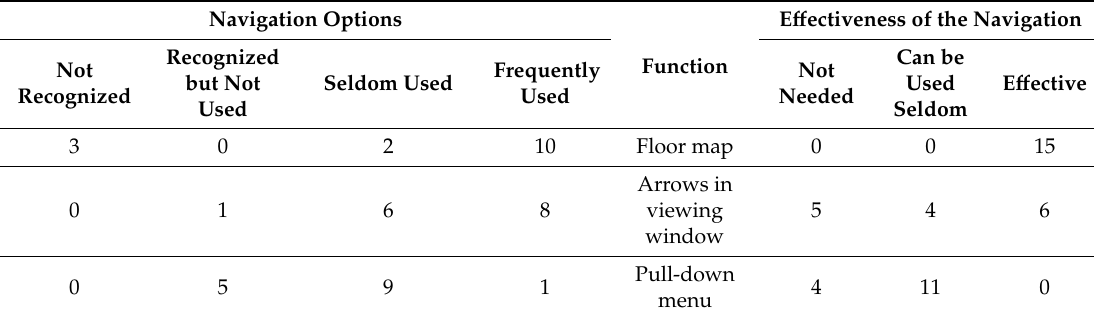
Table 1. Usability assessment